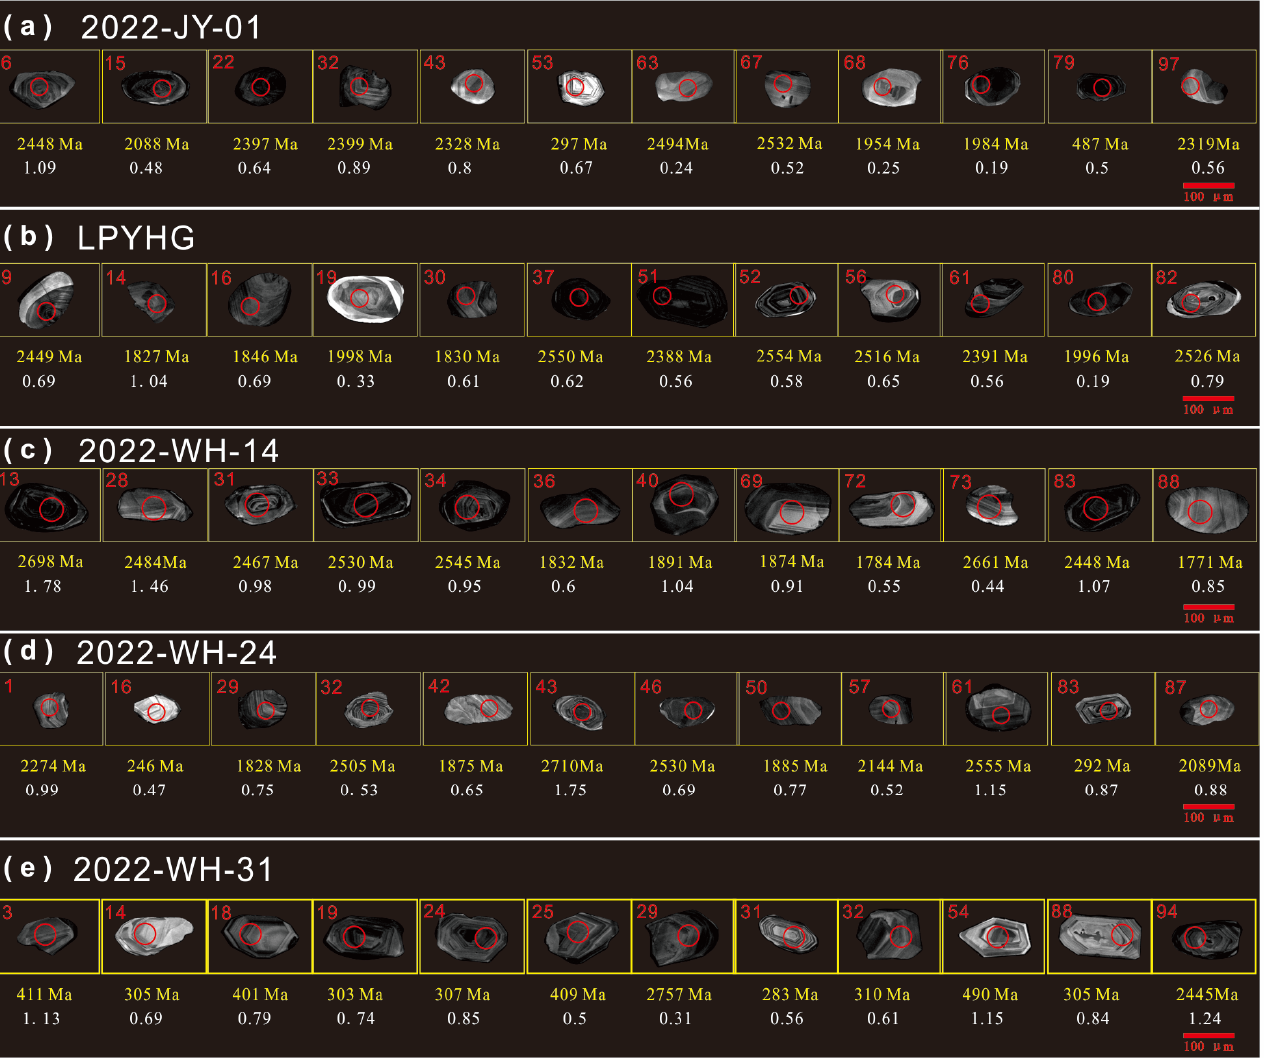
Figure 8. Representative cathodoluminescence images of analyzed zircons from Carboniferous and Permian samples from the Proto ‐ Helanshan Basin, with red circles showing analytical spots and yellow and white numbers displaying corresponding U ‐ Pb ages and Th/U ratios, respectively. Sam ‐ ple labels: ( a ), 2022 ‐ JY ‐ 01; ( b ), LPYHG; ( c ), 2022 ‐ WH ‐ 14; ( d ), 2022 ‐ WH ‐ 24; ( e ), 2022 ‐ WH ‐ 31.